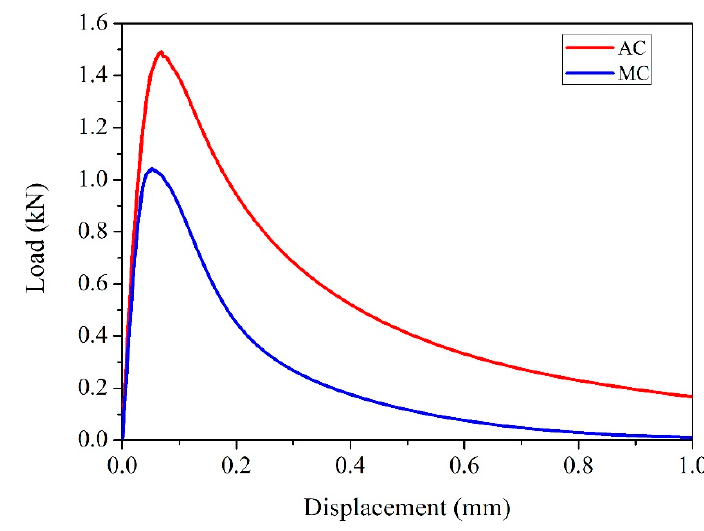
Figure 2. Load-CMOD relation curves of AC and MC illustrating their different levels of fracture strength.